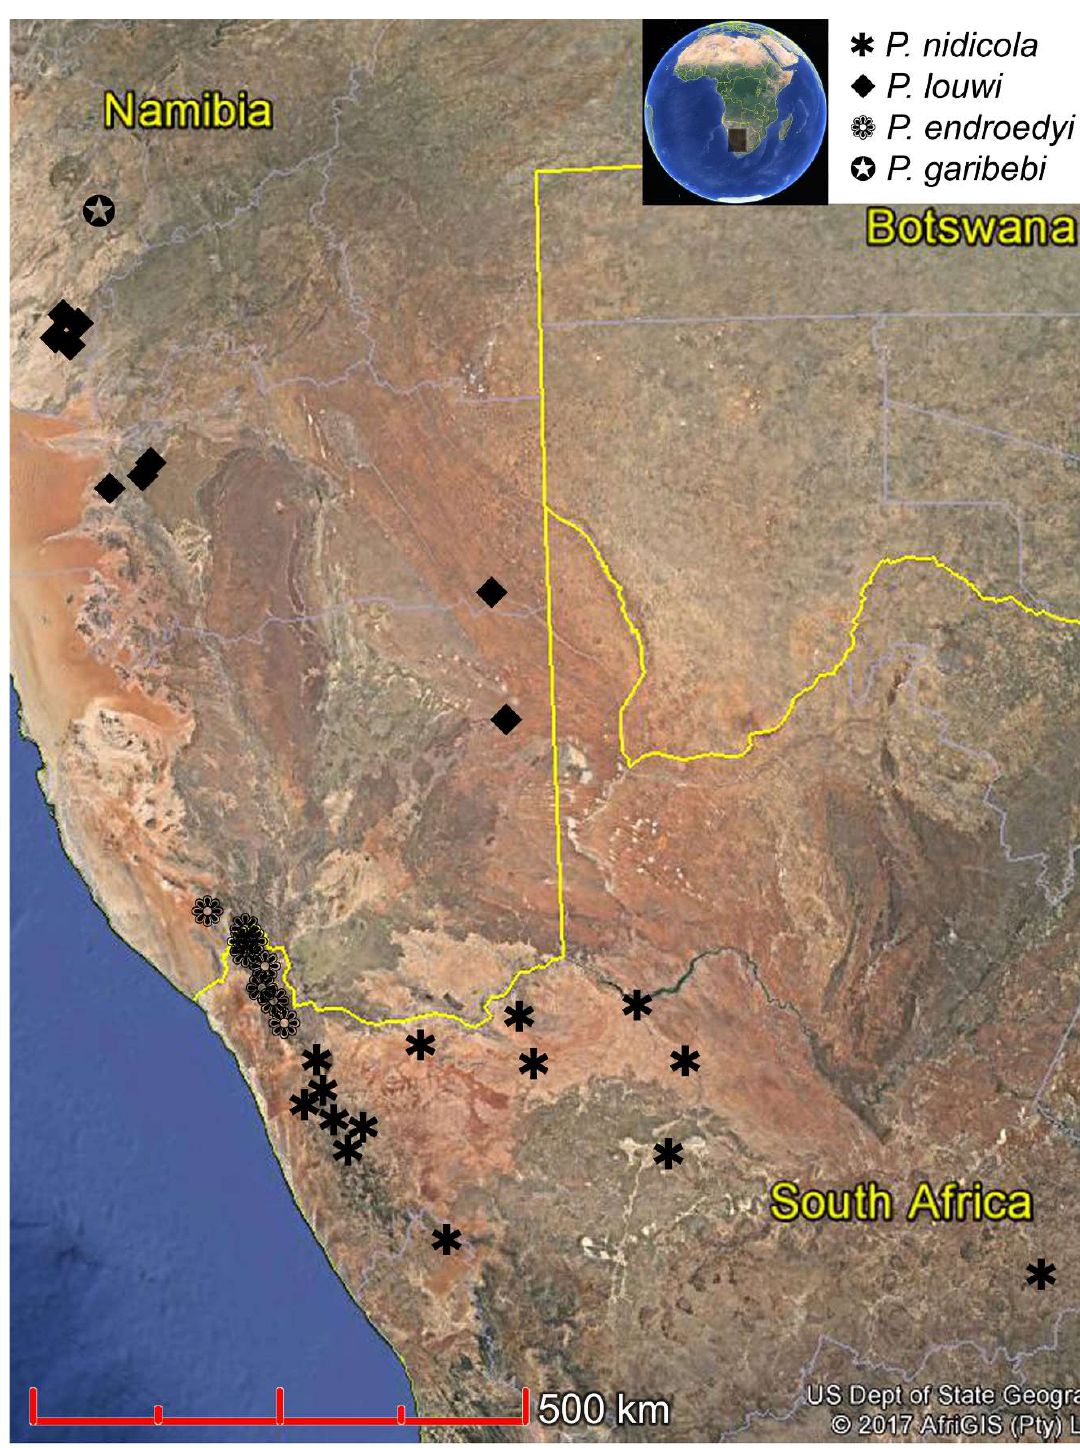
Figure 10. Recorded distribution of Philetaerobius in southern Namibia and north-western South